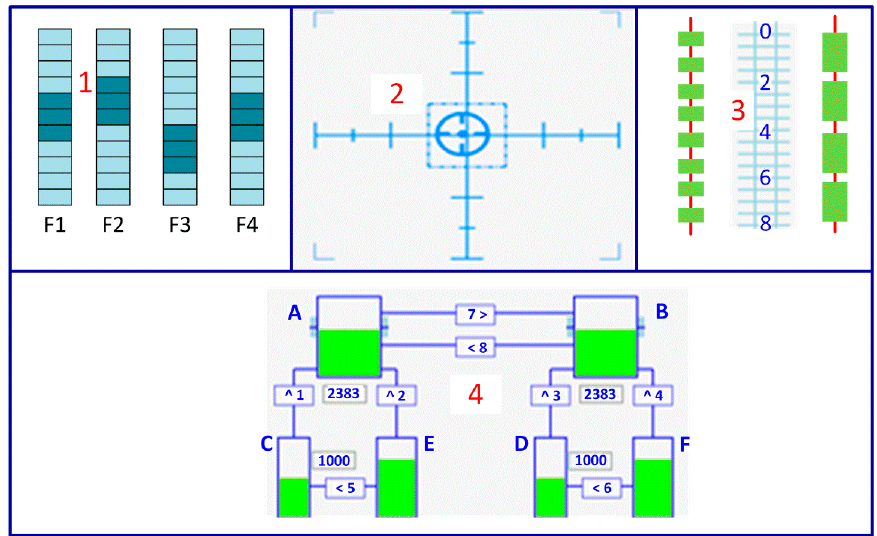
Figure 2. Task interface of MATB-II.